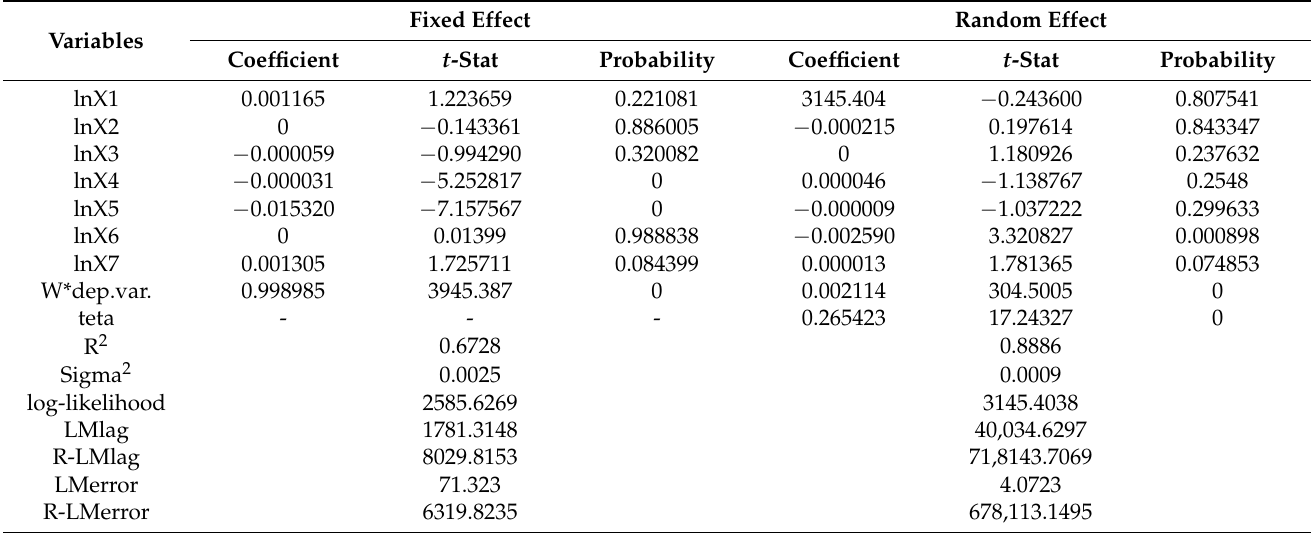
Table 6. Estimation results of spatial lag evaluation model for urban human settlements